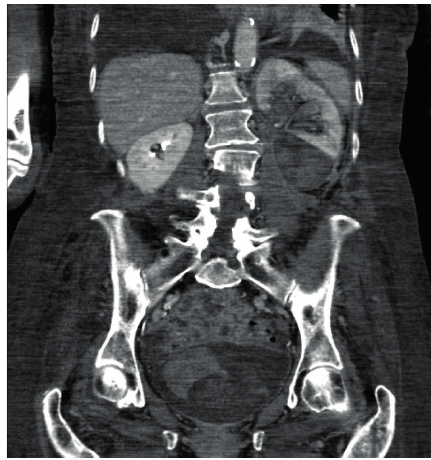
Figure 4: Split bolus contrast CT KUB: coronal section.